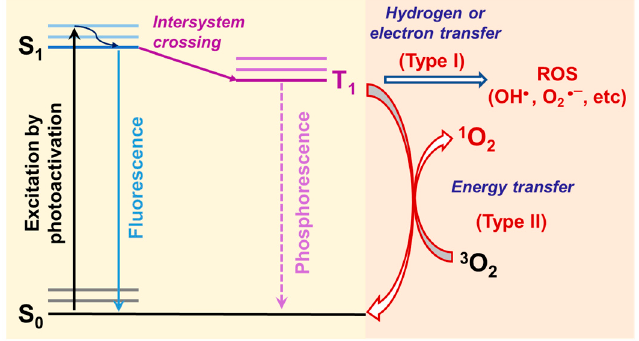
Scheme 1. Photophysical processes involved in